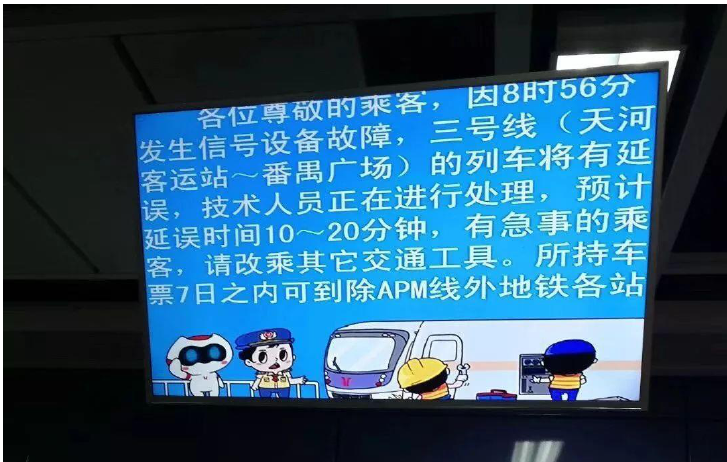
Figure 1. Delay information sent out by PIDS in the GZM network.